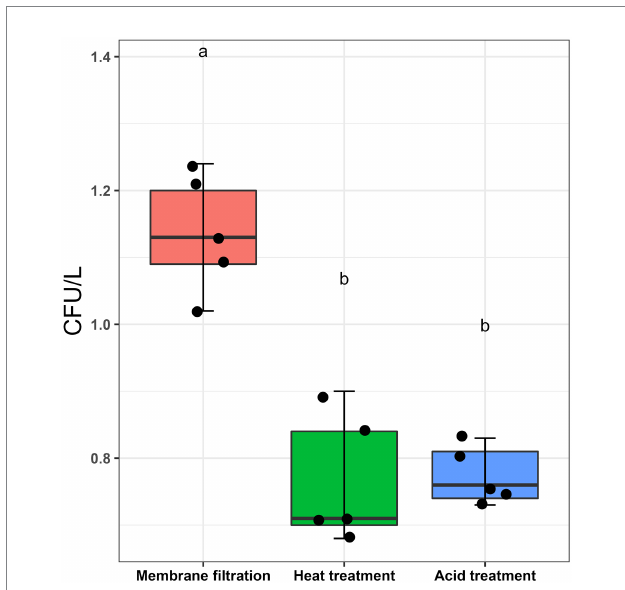
FIGURE 1 Effect of sampling processing methods (ISO11731:2017-05) on L. pneumophila culturability. L. pneumophila spiked water samples were membrane filtered (no pre-treatment used as control), followed by heat (50 ° C/30 min) and acid (KCl-HCl with pH 2.2/5 min) pre-treatment method. These pretreatment methods transformed ≈ 30% culturable Legionella into a non-culturable state. Data are the mean with standard deviation of five replicates, while the same letter within the same treatment is statistically similar according to Tukey’s HSD test ( p <